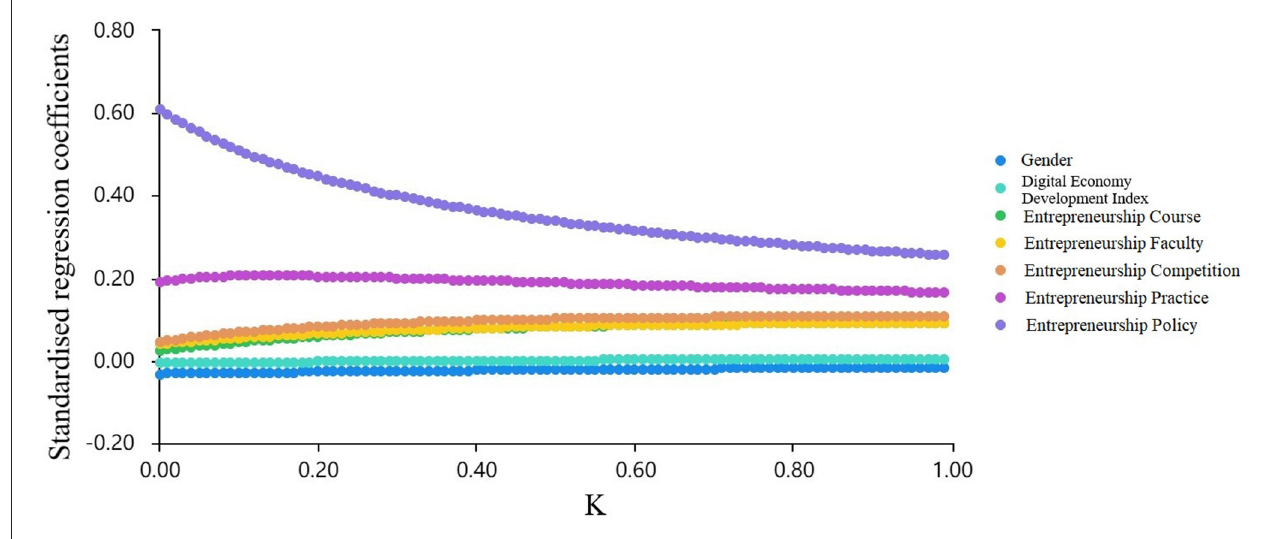
FIGURE 2 | Ridge trace plot.